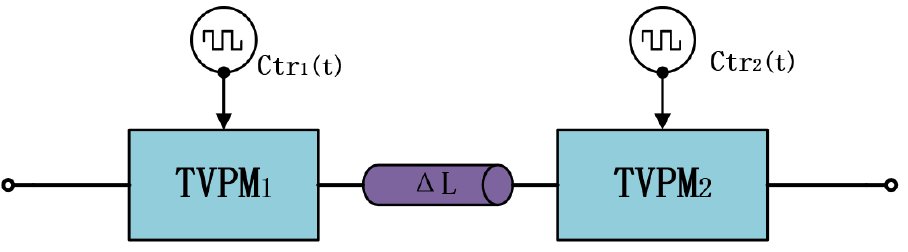
Figure 3. Structure of gyrator .